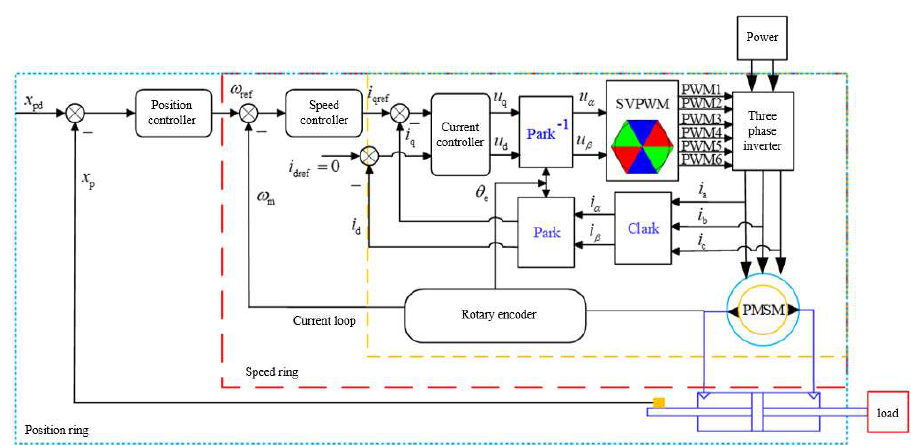
Figure 4. Position control three-loop diagram of the pump control system.